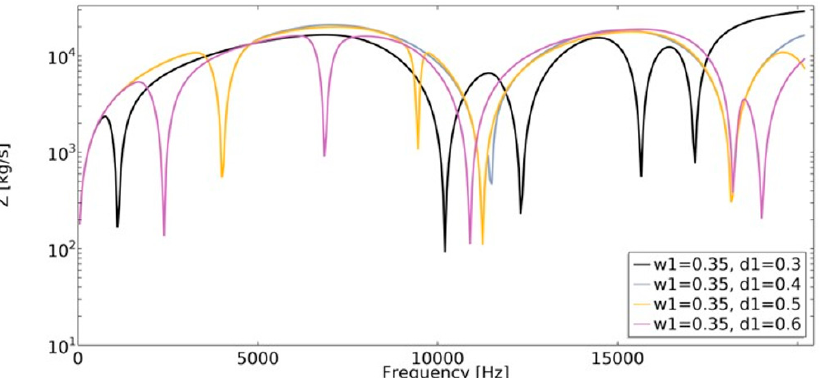
Figure 19. The influence of geometric features on the value of mechanical impedance in the frequency range of 1–20,200 Hz for w 1 = 0.35.